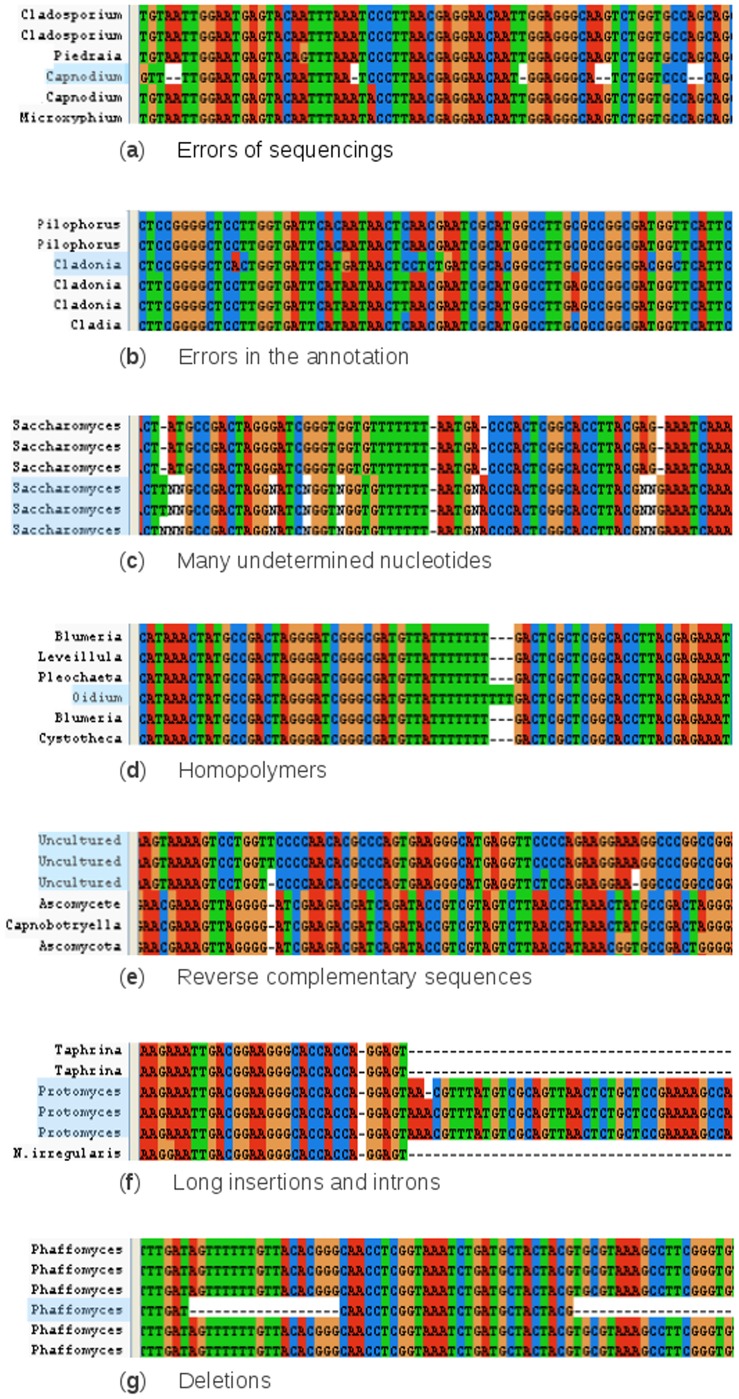
Visualisation of sequences deleted by the manual curation after alignment (ClustalX 2.1).The sequences highlighted in blue illustrate examples of sequences removed from PHYMYCO-DB. The compromised nature can stem from erroneous sequencing (e.g. repeated gaps), wrong annotation (e.g. sequence corresponding to another clade), high numbers of undetermined nucleotides, homopolymers insertions, erroneous alignment or reverse complementary sequences and presence of long insertions and introns or presence of deletions.